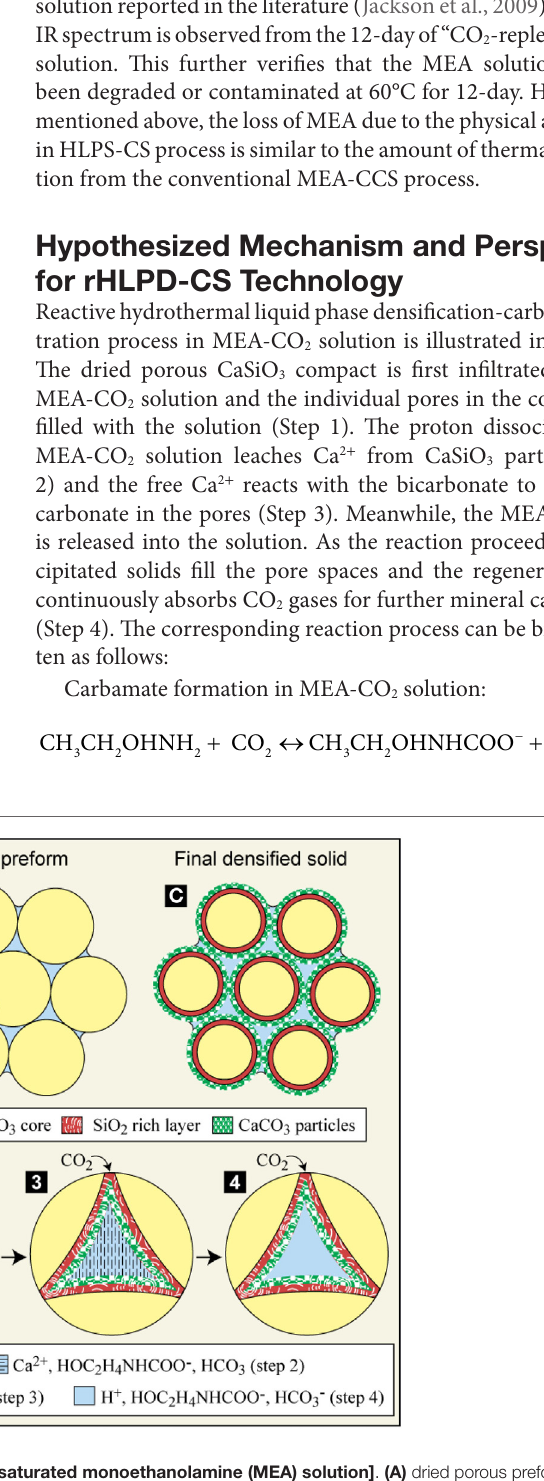
FigUre 7 | schematics of rhlPD process [carbonation of casiO 3 in cO 2 saturated monoethanolamine (Mea) solution] . (a) dried porous preform (compact); (B) fully wet preform (compact) in CO 2 saturated MEA solution; (c) densified solid in MEA-CO 2 solution. Steps 1–4 show how the carbonation process occurs in the individual pores: Step 1 – CO 2 -saturated MEA solution in the pore; Step 2 – Ca 2 + is leached by proton; Step 3 – precipitation of solids (CaCO 3 and amorphous silica in this paper) and regeneration of MEA solution; Step 4 – CO 2 saturated MEA solution in the